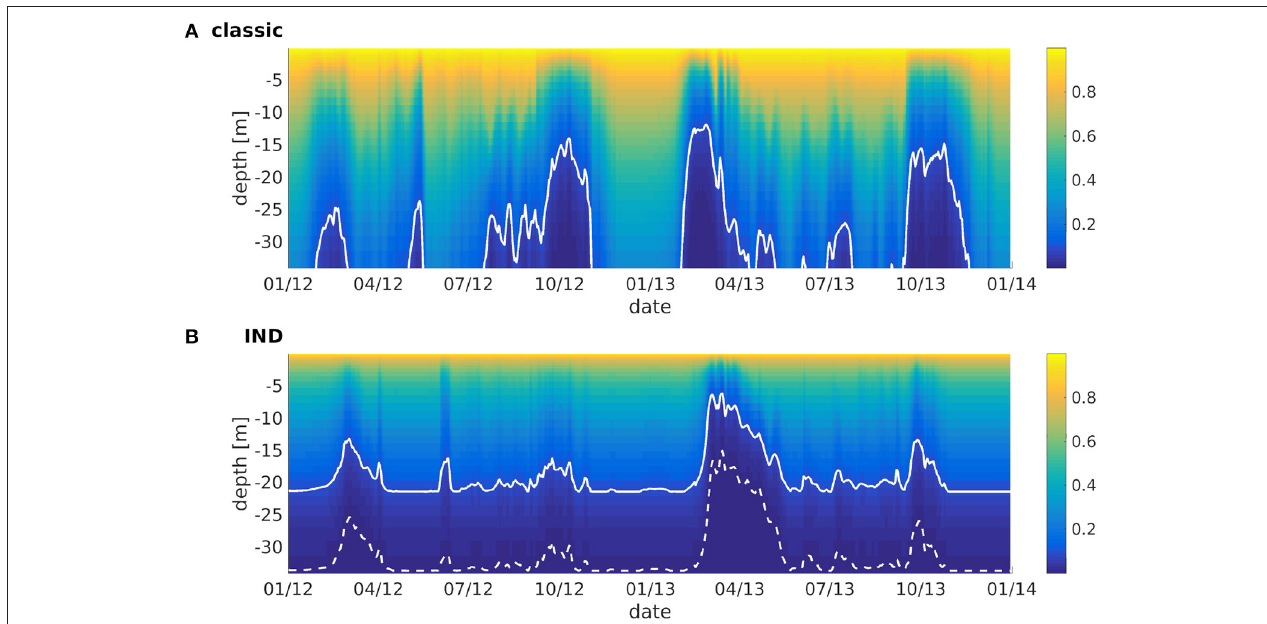
FIGURE 7 | Normalized irradiance at depth vs. time for ROMS-CoSiNE at the station marked by the black cross in Figure 1 using (A) the classic formulation and (B) the IND scheme. The solid line denotes the 10 % -, and the dashed line the 1 % -depth.